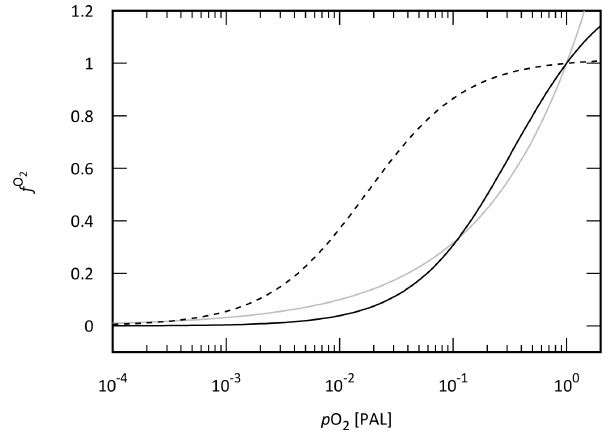
Figure 10. O 2 dependency of the oxidative weathering rate of or- ganic matter and pyrite sulfur. The gray line denotes the ( p O PAL relationship assumed in previous biogeochemical models (Lasaga and Ohmoto, 2002; Daines et al., 2017). Solid and dashed black lines represent the empirical Monod-type relationships for oxida- tive weathering of organic matter (solid) and pyrite sulfur (dashed) based on the results obtained from a 1-D weathering model (Bolton et al., 2006; Daines et al., 2017), which are adopted in the standard model of the CANOPS-GRB model. PAL stands for present atmo- spheric